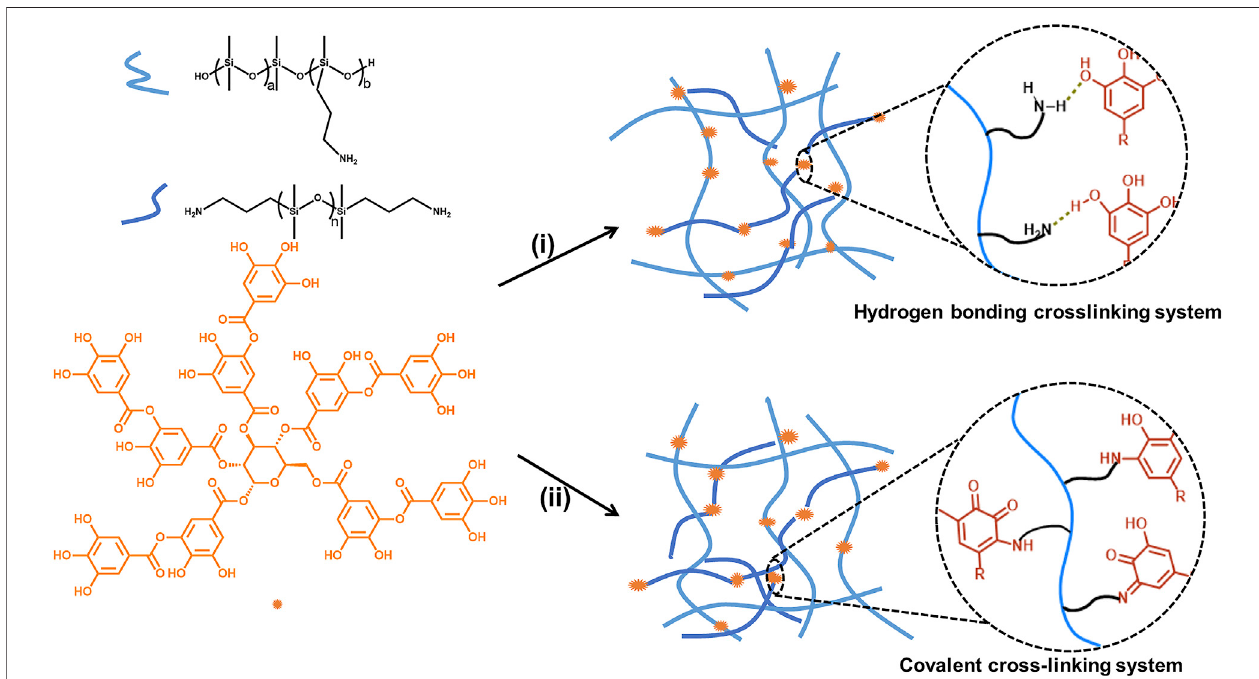
FIGURE 1 | Preparation of silicone elastomers crosslinked by hydrogen bonding or covalent bonding. (i) H 2 O/solvent, room temperature; (ii) H 2 O/solvent, room temperature; 150 ° C, 1 h.